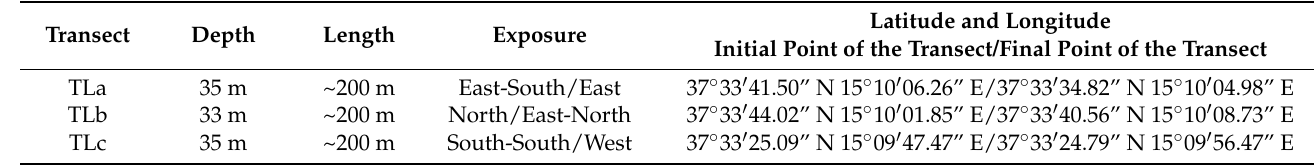
Table 1. Summary table of ROV transects.